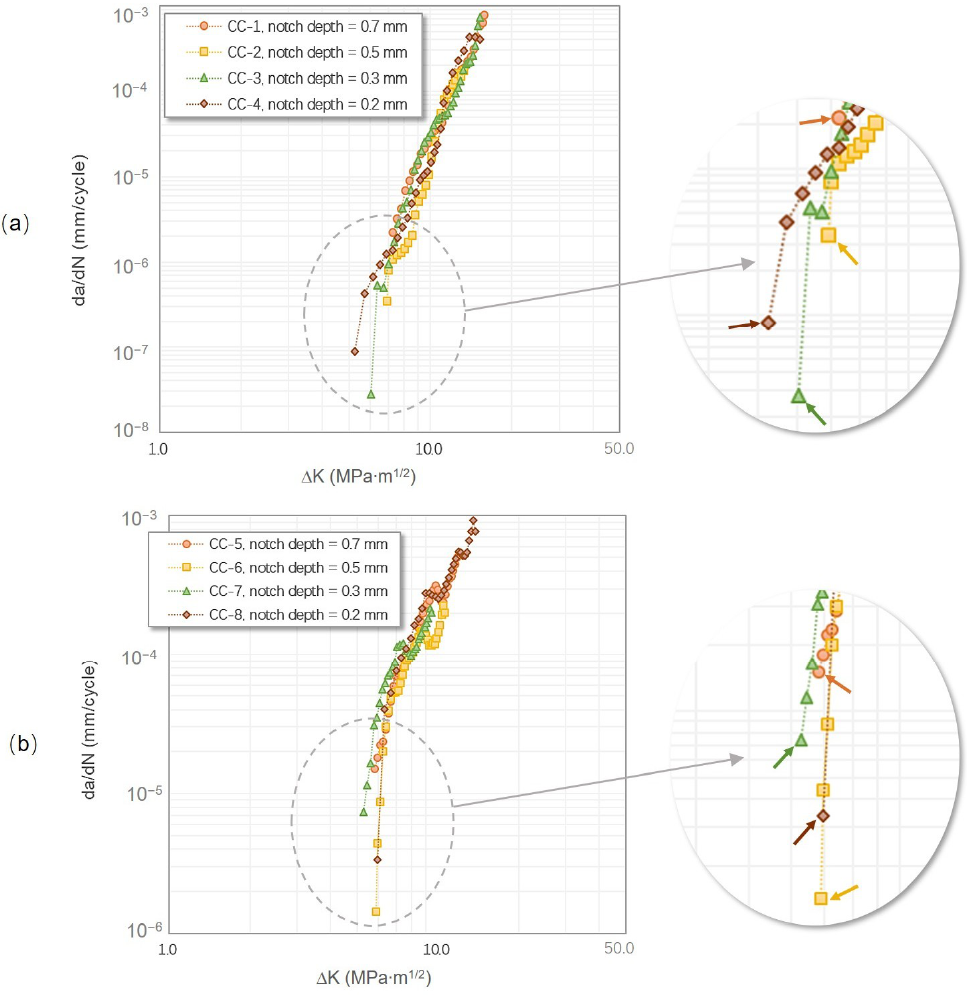
Figure 4. FCG curves of tests carried out using the ∆ K-increasing method in the CC specimens: ( a ) at room temperature (RT) with an R ratio of 0.1 and ( b ) at 650 °C with an R ratio of 0.1. For comparison purposes, all the tests were directly started from the notch root without precracking. The fatigue threshold values are indicated by